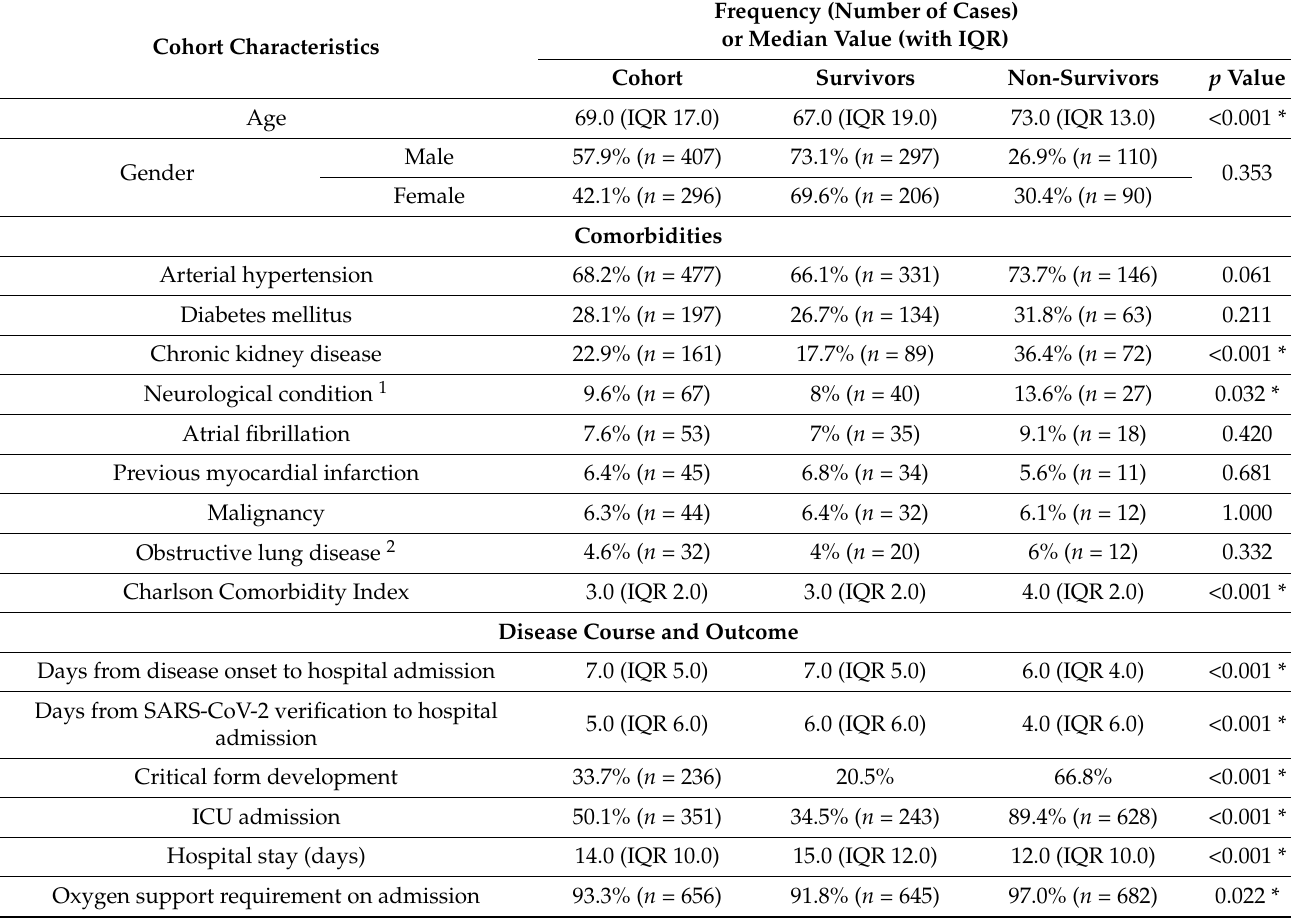
Table 1. Demographic and medical history characteristics of COVID-19 survivors and